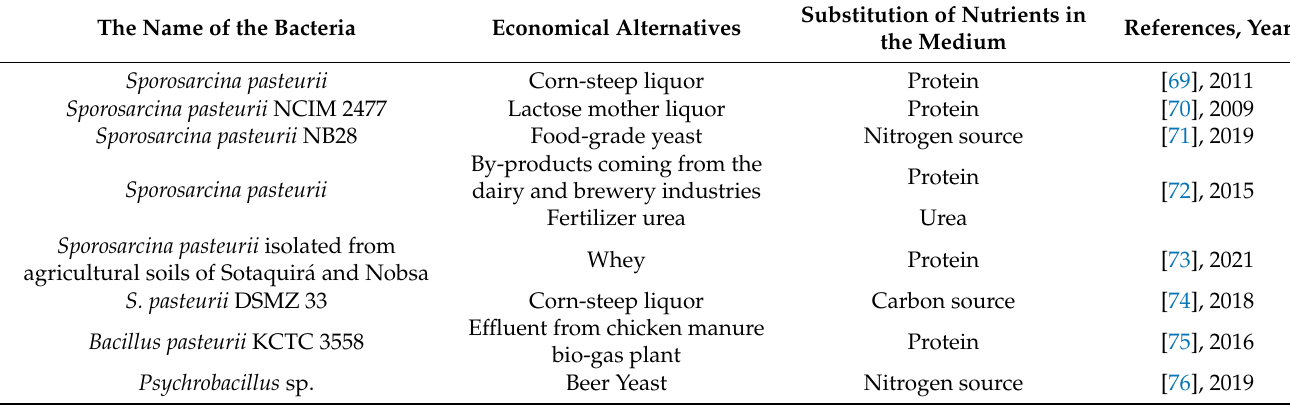
Table 2. Economical alternatives to medium nutrient